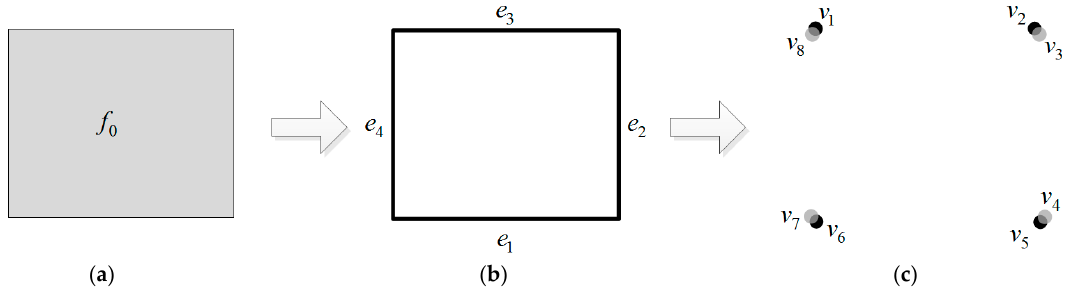
Figure 9. Propagation of extrusion intervals from footprint faces ( a ) to footprint edges ( b ) and then to footprint points ( c ).